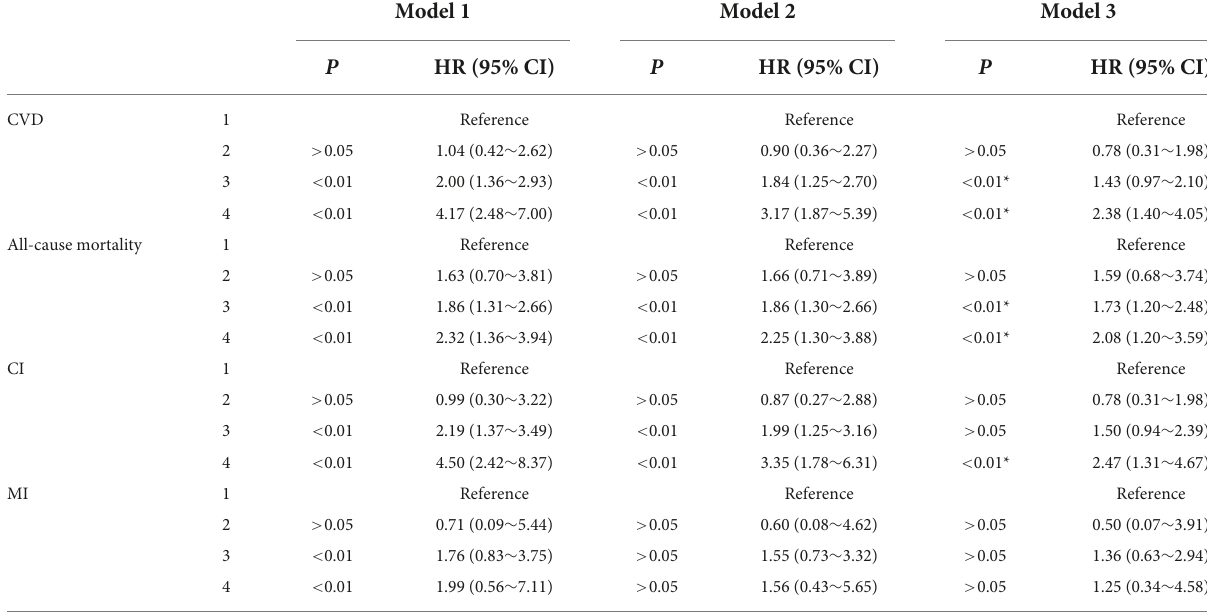
TABLE 3 Multivariable Cox regression analysis for cardiovascular disease events and all-cause